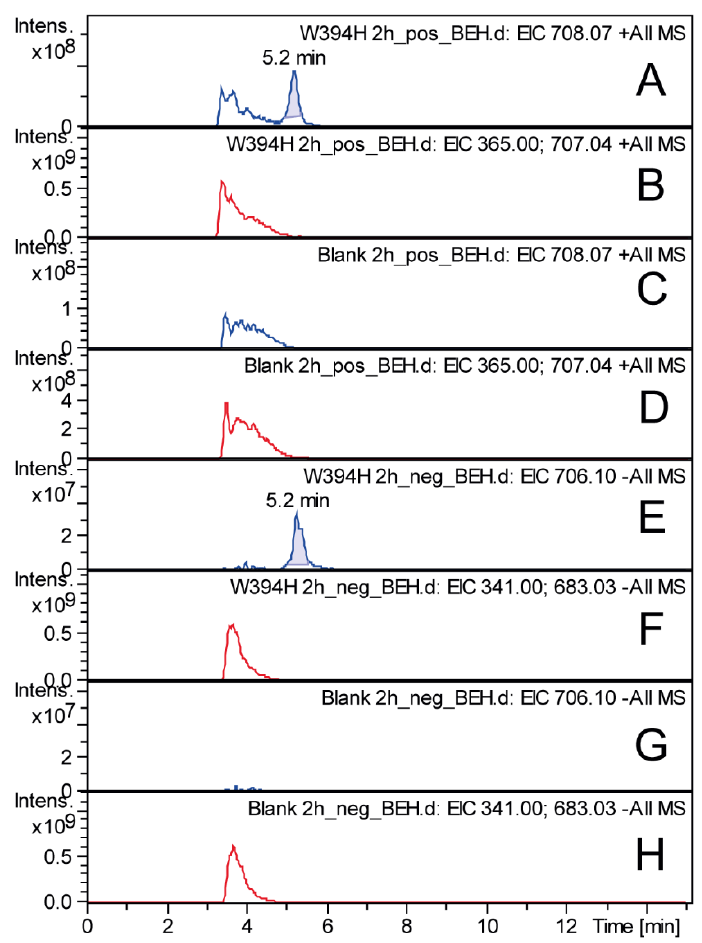
Figure 6. BEH amide chromatography of a representative sample in positive mode ( A – D ) and neg- ative mode ( E – H ). Extracted ion chromatograms of LNT isomers (blue, m / z 708 [M+H] + , m / z 706 [M- [M − H] − ) and lactose (red, m / z 365 [M+Na] + and m / z 683 [2M+H] + , m / z 341 [M − H] − and m / z H] - ) and lactose (red, m / z 365 [M+Na] + and m / z 683 [2M+H] + , m / z 341 [MH] - and m / z 683 [2M-H] - , in a sample ( A , B , E , F ) and a blank reaction added without enzyme ( C , D , G , H ).